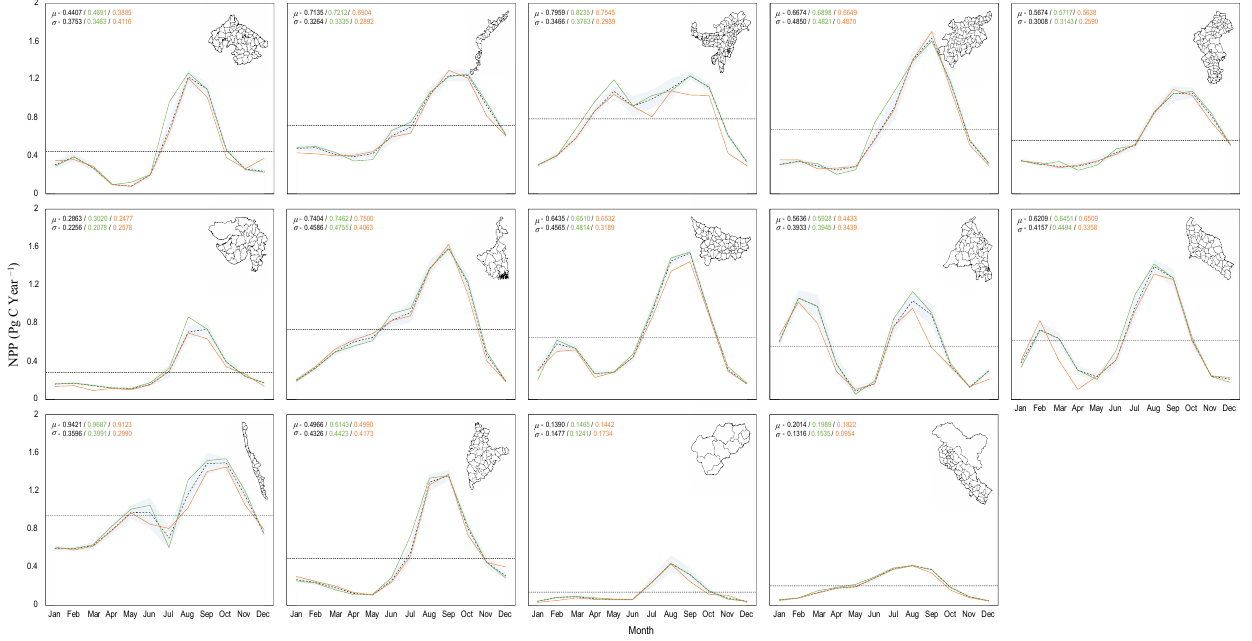
Figure 3. Climatology of monthly mean NPP for the ecological zones of India isolated for 2001–2020. The dashed black line with shading represents the overall monthly mean NPP with uncertainty. The red line indicates the monthly mean of NPP for the years with higher AOD than the threshold, whereas the green line indicates the monthly mean of NPP for the years with lower AOD than the threshold. The horizontal dashed line designates the overall mean. µ and σ signify the seasonal mean and SD, respectively (black—overall NPP; red—NPP for the years with AOD > threshold; green—NPP for years with AOD <